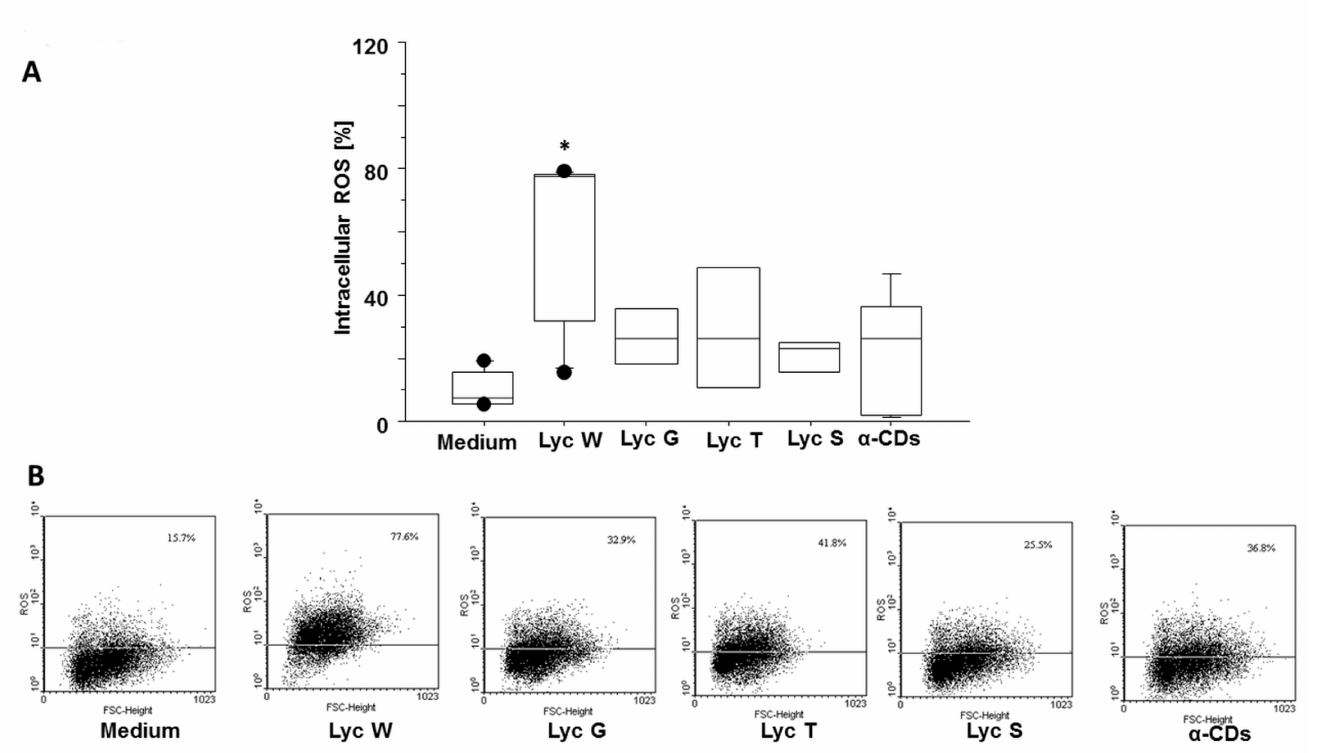
Figure 5. Lyc W affect intracellular ROS generation. ( A ) Lyc W significantly increased intracellular ROS when compared to cells grown in medium or in Lyc G, Lyc T and Lyc S or in its carrier α -CDs. The results are shown as box-plots with medians (lines inside the boxes). Analysis of variance (ANOVA), Fisher’s PLSD, n = five experiments; *, p -value < 0.05. ( B ) representative examples of flow cytometric analysis for percentage of positive cells. The numbers indicate the percentage of positive cells for